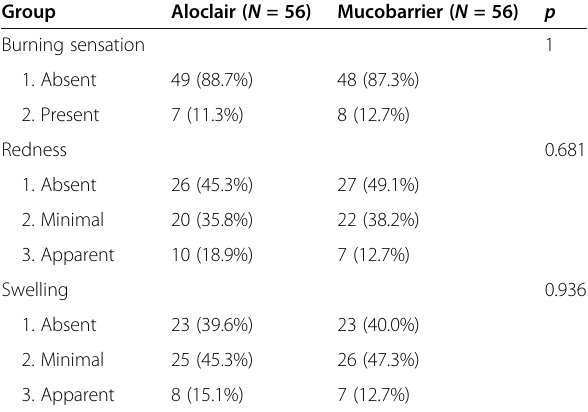
Table 3 Post-operative burning sensation, redness, and swelling